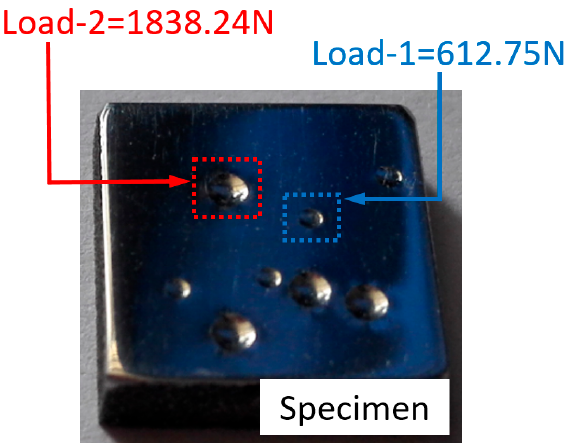
Figure 2. Cubic specimen and residual indentation imprint under two different indentation loads.